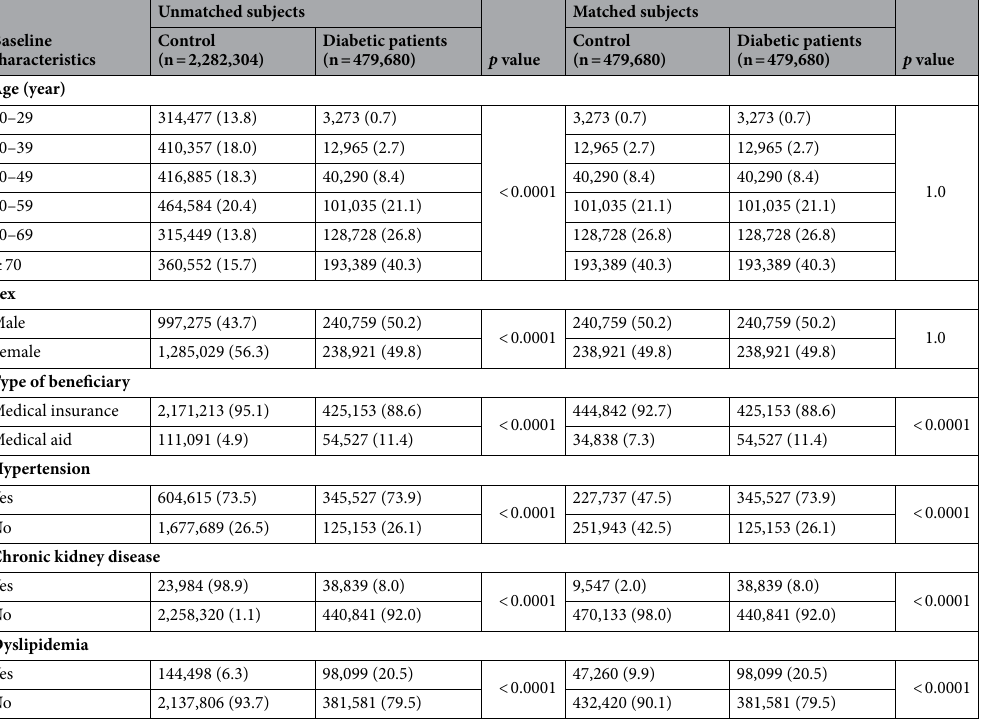
Table 1. Baseline characteristics of patients with type 2 diabetes in unmatched and matched population-based controls. Data are presented as number (percentage,